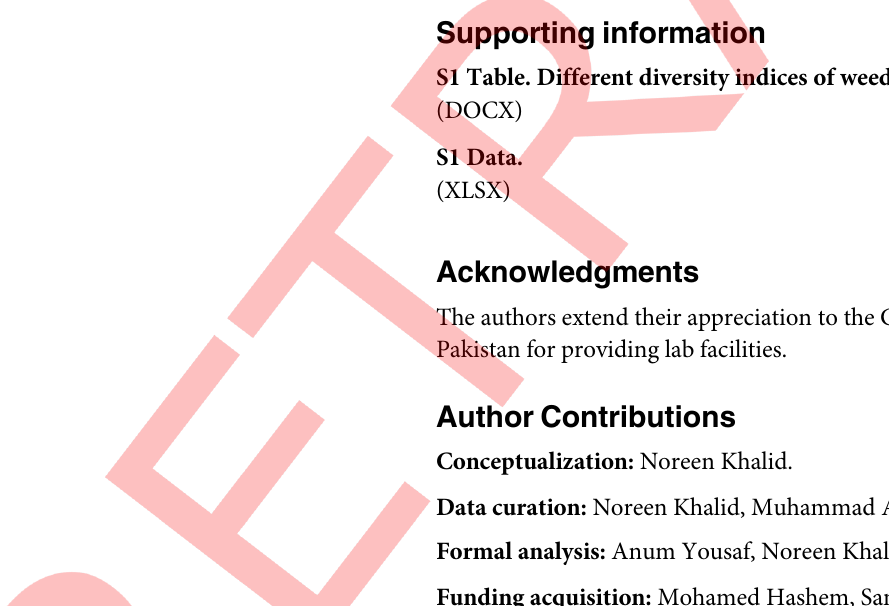
S1 Table. Different diversity indices of weed